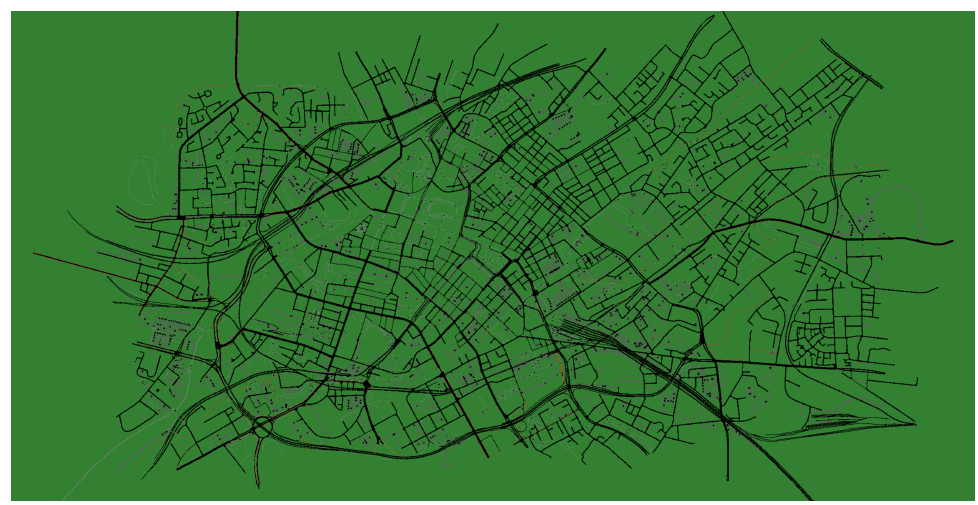
Figure 7. Illustration of Manchester’s city centre road network within